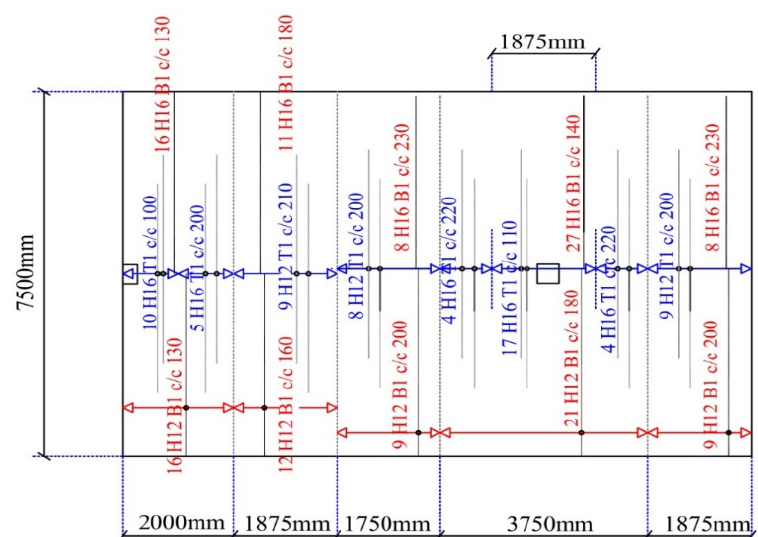
Figure 10. Transverse reinforcement designed for the